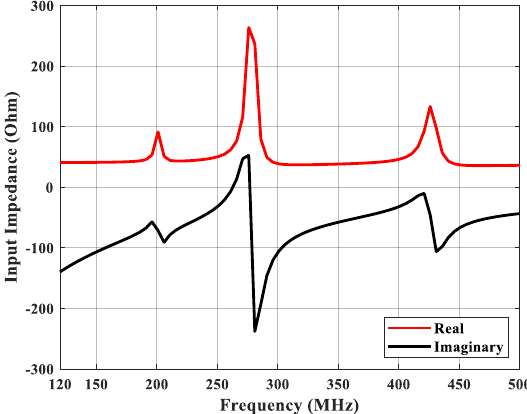
Figure 12. Input impedance of CRLH transmission line antenna.